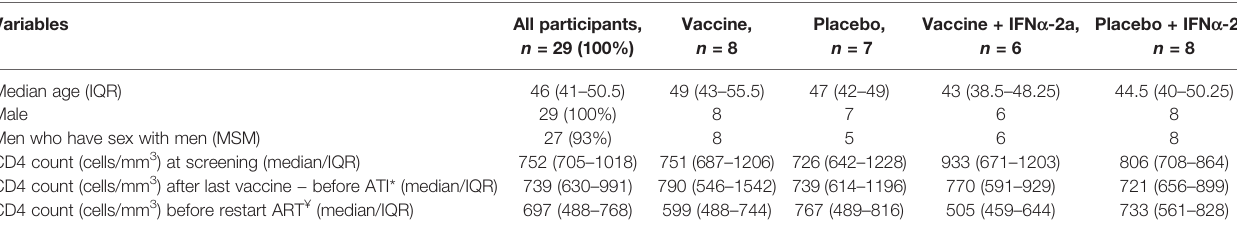
*ATI, Analytical Treatment Interruption; ¥ ART, Antiretroviral Treatment.